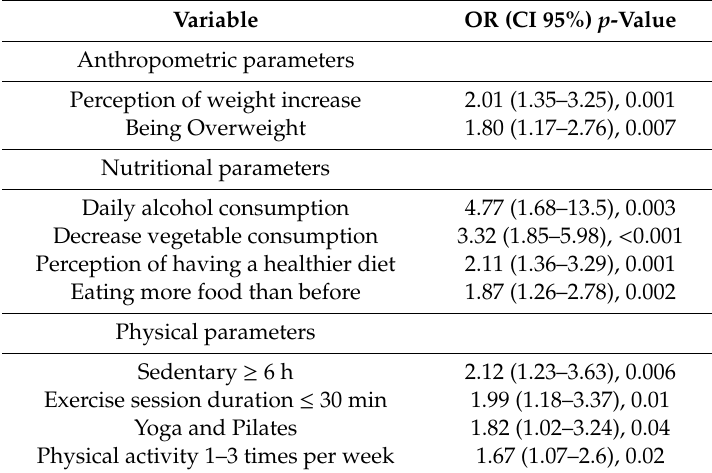
Table 5. Factors related to a decrease in physical activity in COVID-19